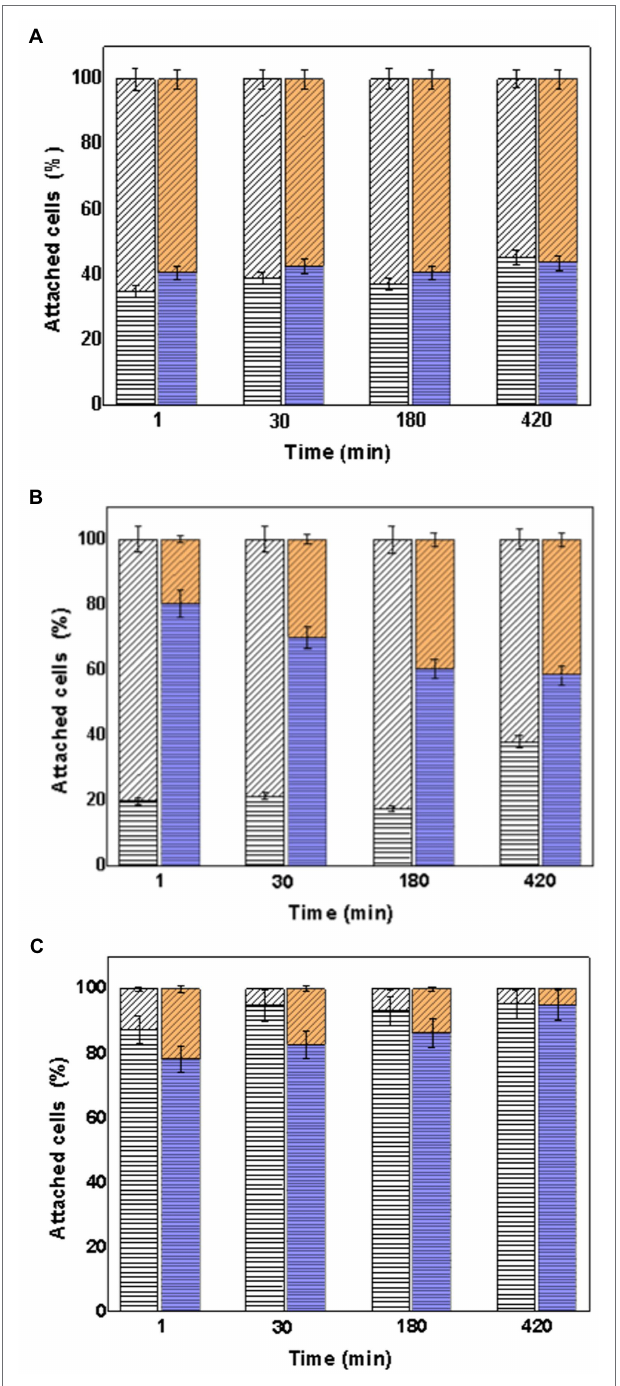
FIGURE 7 | Attachment percentage of the species At. thiooxidans DSM 14887 T and L. ferrooxidans DSM 2705 T on the surface of the mineral particles over time. (A) Consortia in proportion 50:50 of each specie. (B) Consortia in proportion 70:30 of At. thiooxidans DSM 14887 T and L. ferrooxidans DSM 2705 T , respectively. (C) Consortia in proportion 30:70 of At. thiooxidans DSM 14887 T and L. ferrooxidans DSM 2705 T , respectively. At. thiooxidans DSM 14887 T (diagonal lines) and L. ferrooxidans DSM 2705 T (horizontal lines). White Bars represent the control. Color Bars represent consortia adapted to D-galactose. The data correspond to the mean values of triplicates ± SD ( n =